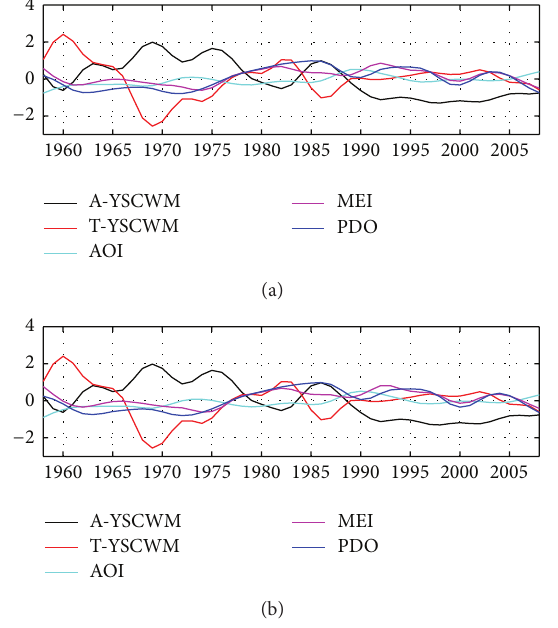
Figure 8: Decadal time series of (a) winter AO, MEI, and PDO index, and the A-YSCWM and T-YSCWM in August (b) summer AO, MEI, and PDO index, and the A-YSCWM and T-YSCWM in August. Time series of the A-YSCWM and T-YSCWM are standardized. The A-YSCWM and T-YSCWM represent the area and averaged temperature of the YSCWM, respectively.